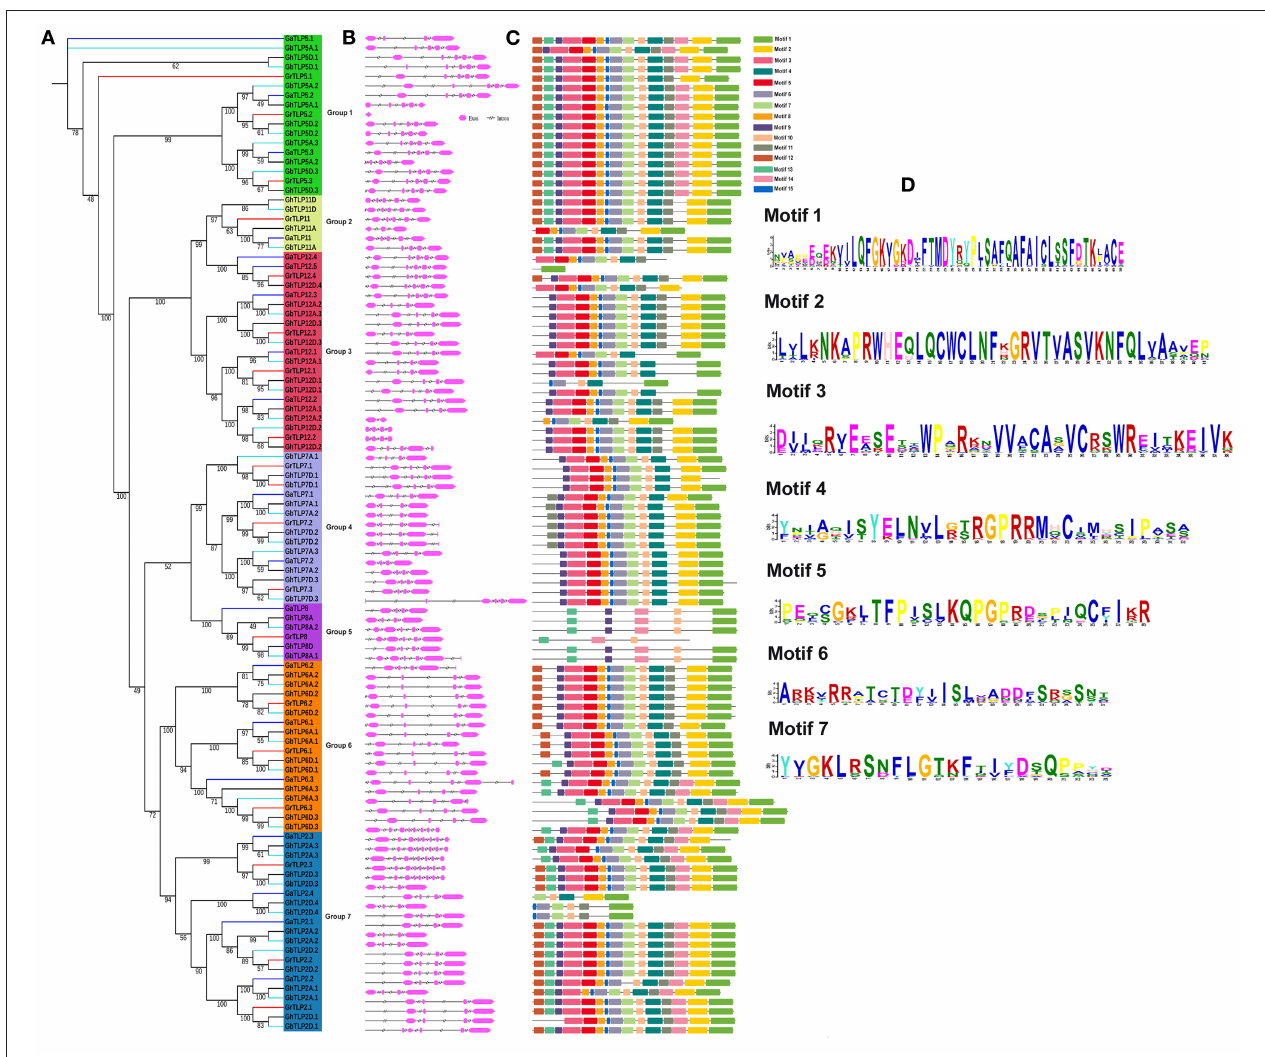
FIGURE 3 | Phylogenetic tree, gene structure, and conserved protein motifs analysis of TLPs in G. arboreum, G. raimondii, G. hirsutum , and G. barbadense . (A) Phylogenetic tree of G. arboreum, G. raimondii, G. hirsutum , and G. barbadense TLPs built with the ML (maximum likelihood) method and using 1,000 bootstrap values. Different colors of lines denoted the different species of Gossypium (Blue, G. arboreum ; Red, G. raimondii ; Black, G. hirsutum ; and cyan, G. barbadense ). Groups 1–7 distributed in green, yellow, red, royal, violet, orange, and sky blue colors, respectively. (B) Showing the exon-intron organization of TLPs genes in Gossypium (Pink boxes, exon, and black lines, introns). (C) Identified conserved protein motifs in the Gossypium TLPs , and each motif is indicated with a specific color. (D) The logos are given for functionally annotated motifs only, where the heights of logo depict the degree of conservation of amino acid within the motif. The motifs order corresponds to their positions in protein sequence. Motif descriptions are given in Supplementary Table 3 .